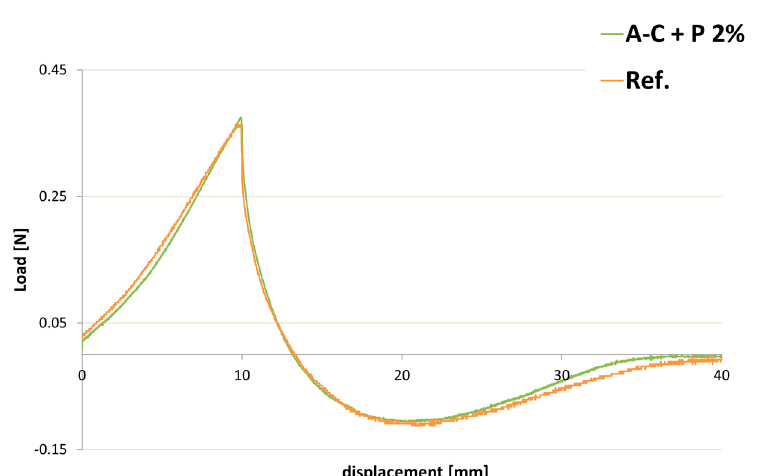
Figure 18. Comparison between the texture profile of the sample prepared with the ternary association of A (1.25% w/w), C (1% w/w), and P (2% w/w), and of the reference product (Ref.). The results from the controlled shear rate tests showed that the A–C mixture with P at 2% w/w and the reference product had similar zero-shear viscosity ( η 0 ) values, calculated using the Carreau–Yasuda model (Figure 19).